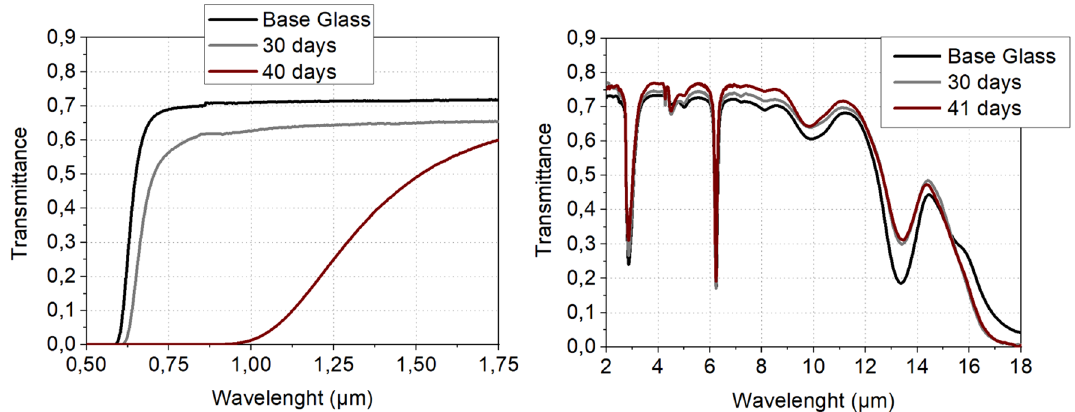
Figure 5. IR transmission of (72 GeSe2–28 Ga2Se3)75 (NaI) 25 samples before and after immersion for different duration in the 60 KNO 3 /40 NaNO 3 bath at 250